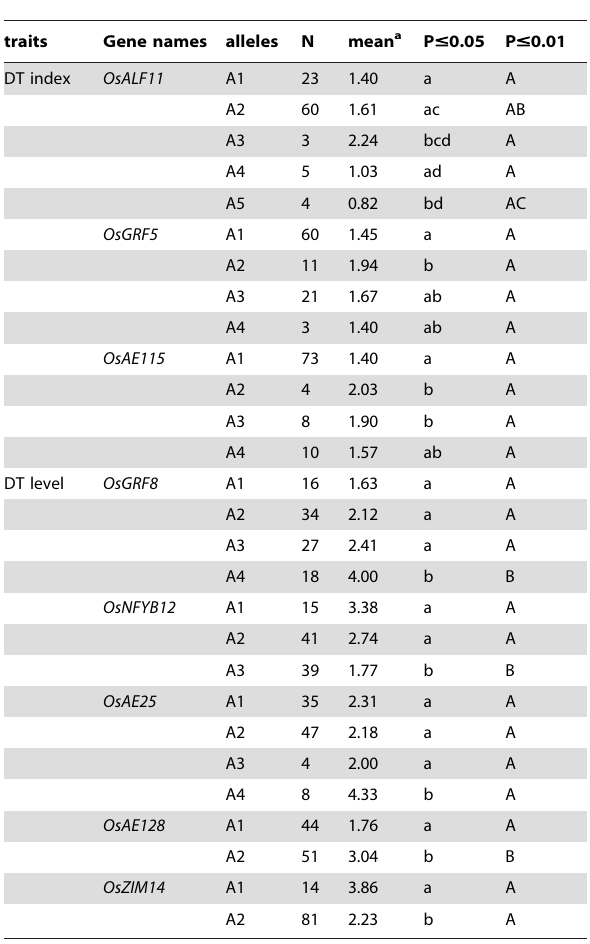
Table 4. Multiple comparisons among means of accessions grouped by the alleles of associated markers.